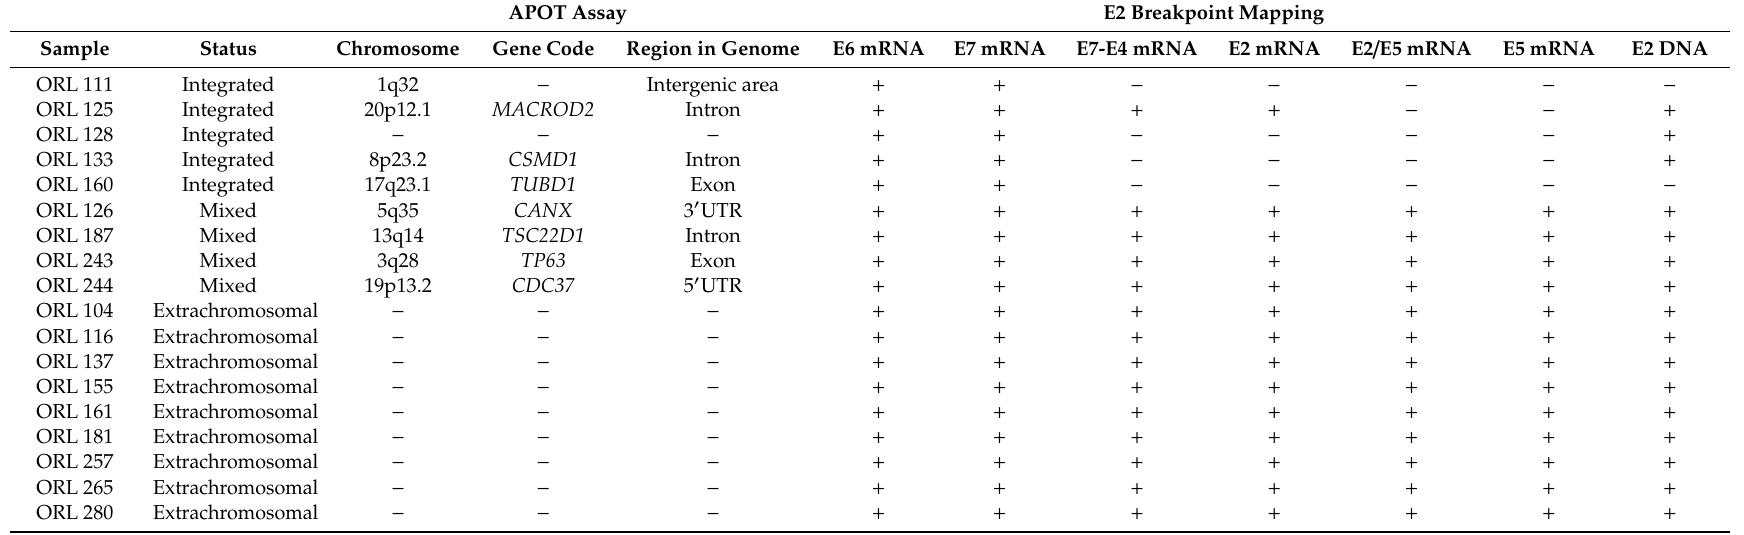
Table 1. HPV16 integration sites in the host genome. Identified by the APOT assay, E2 breakpoint mapping and PCR E2 in OPC samples with integrated or mixed viral